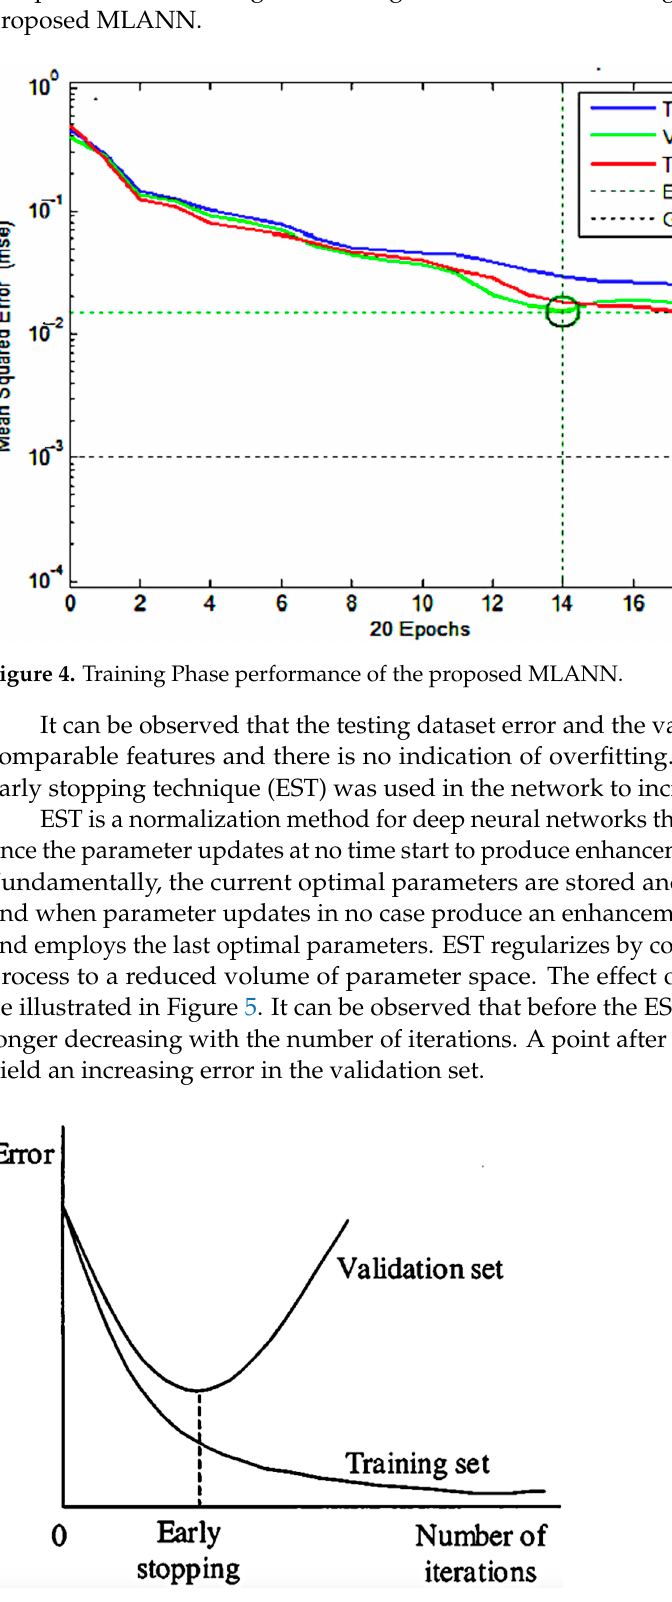
Figure 5. Principle of early stopping on proposed MLANN.